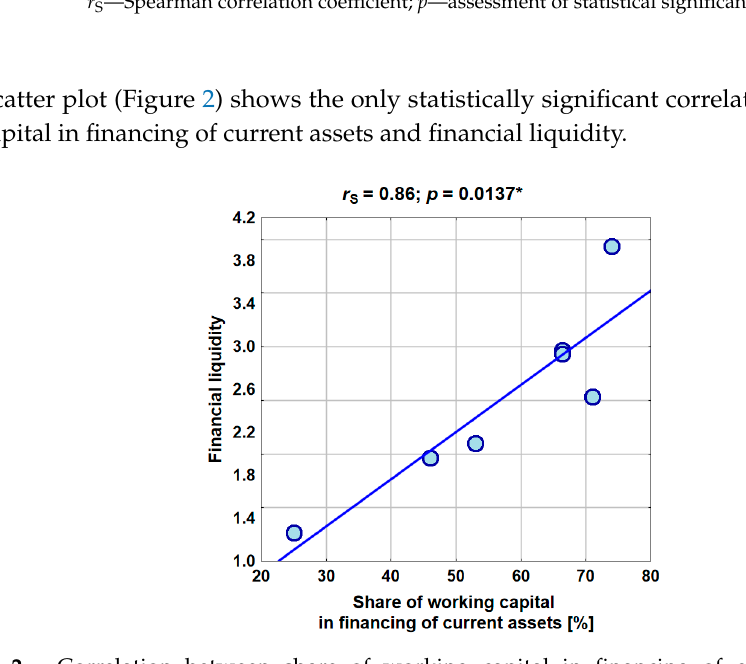
Figure 2. Correlation between share of working capital in financing of current assets and financial